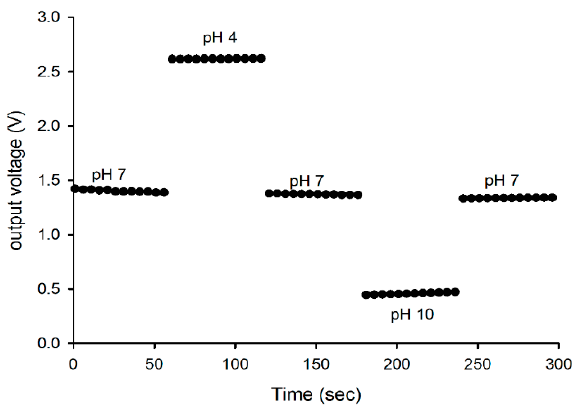
Figure 9. Hysteresis characteristics for prepared PSi membrane EGFET pH sensor.